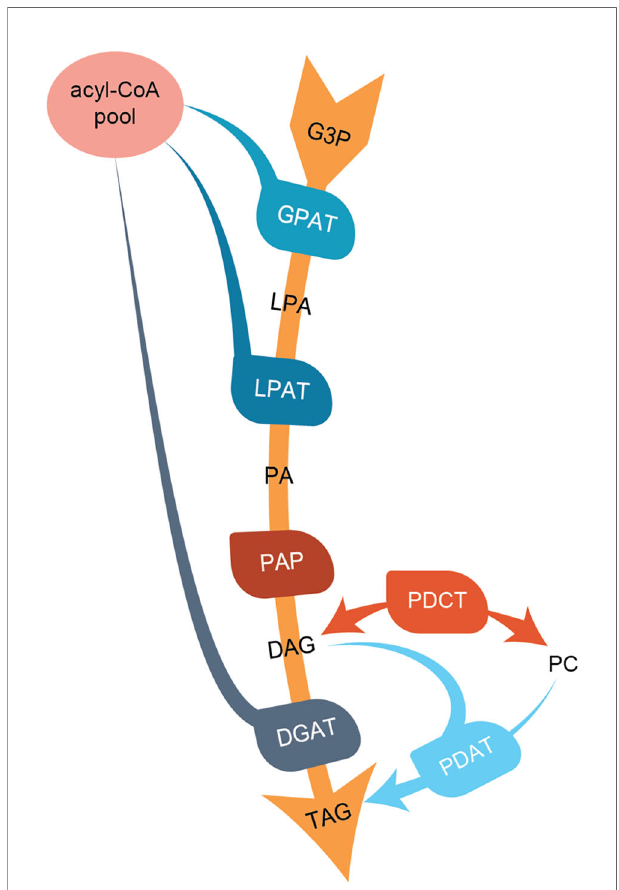
FIGURE 1 | Overview of the de-novo triacylglycerol formation in seeds. Abbreviations for lipids (black letters): G3P, glycerol-3-phosphate; LPA, lyso-phosphoatidic acid; PA, phosphatidic acid; DAG, diacylglycerol; PC, phosphatidylcholine; TAG, triacylglycerol. Abbreviations for enzymes (white letters): GPAT, G3P acyltransferase; LPAT, lysophosphatidylacyltransferase; PAP, Phosphatidate phosphatase; PDCT, PC : DAG cholinephosphotransferase; DGAT, acyl-CoA : DAG acyltransferase; PDAT, phospholipid:DAG